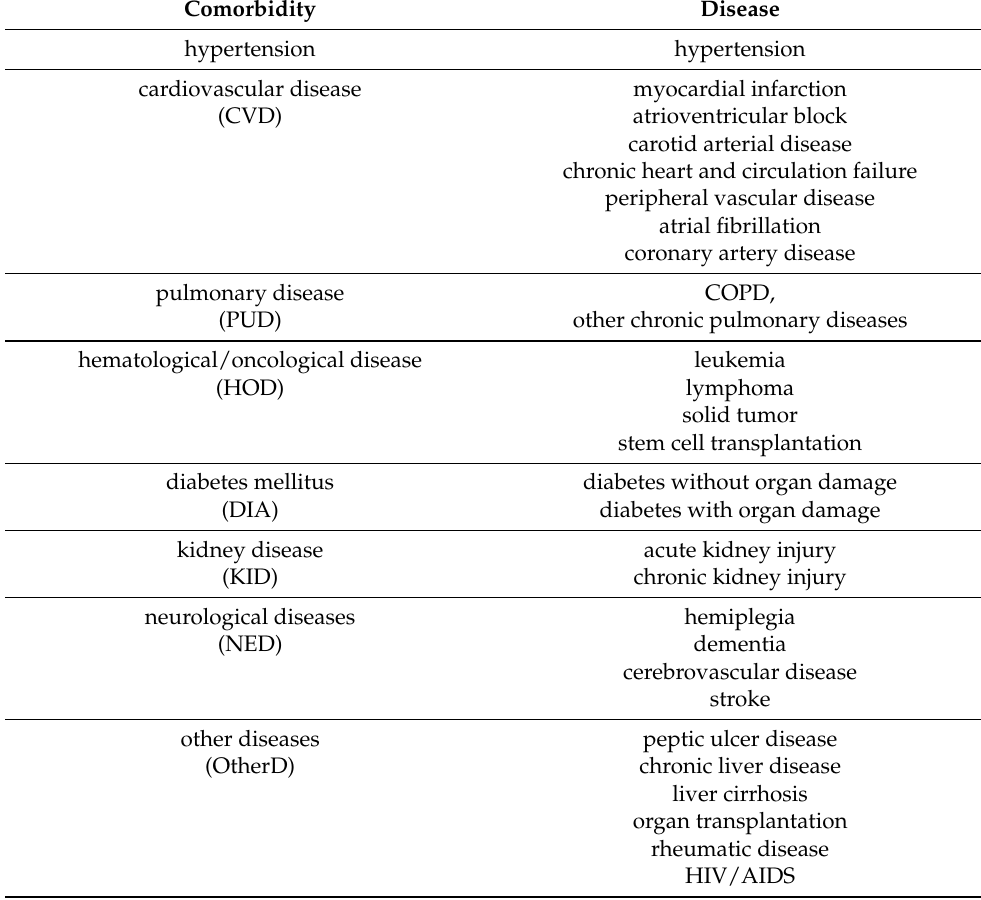
Table 1. Comorbidities formed by aggregating groups of diseases. A comorbidity was recorded if at least one specific disease was